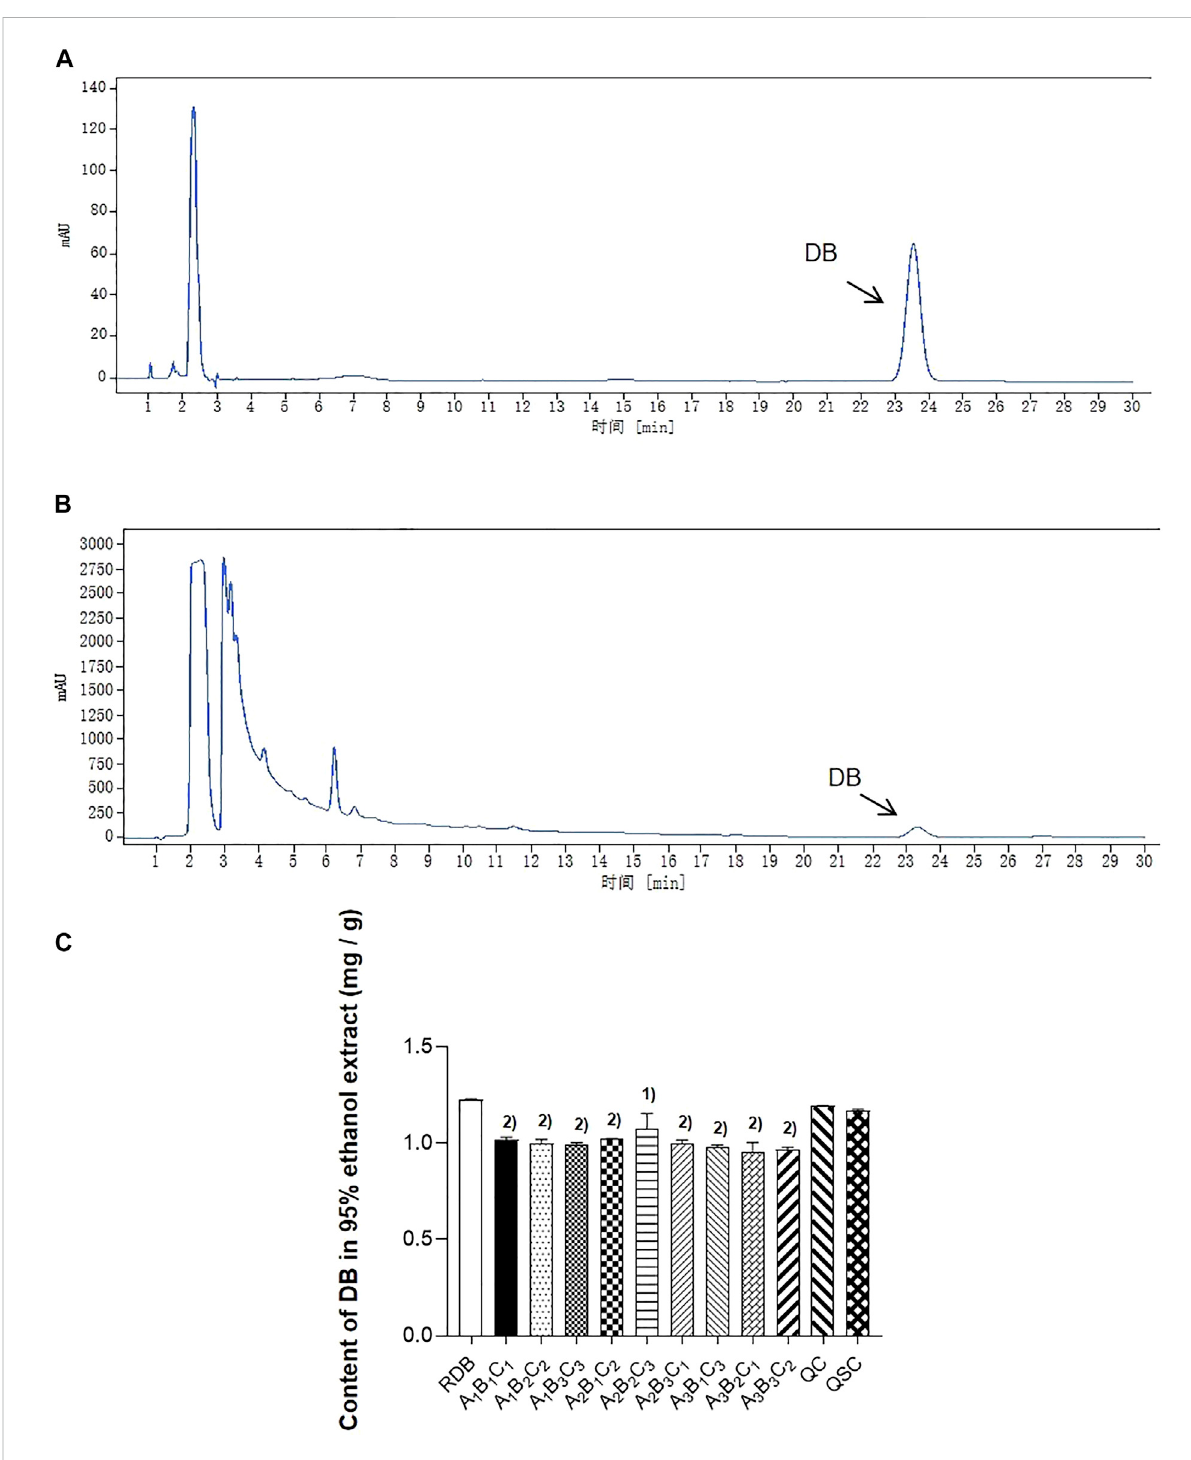
FIGURE 1 Processing with ASR alleviated the content of DB in RDB group. (A) The reference substance of DB in HPLC. (B) The sample of DB in HPLC. (C) The content of DB in RDB and other processed group. Data were expressed as mean ± S.E.M., with three samples in each group. 1) p < 0.05, 2) p < 0.01, compared with the RDB